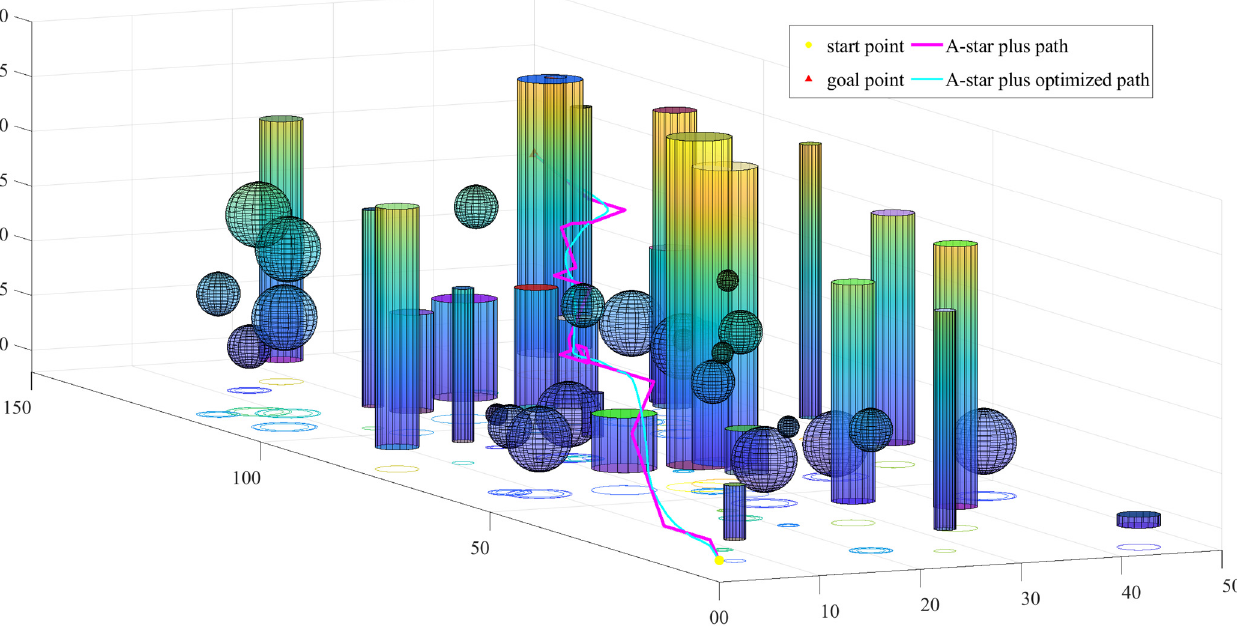
Figure 9. The fitting result of the improved algorithm on a 50 × 150 size map.